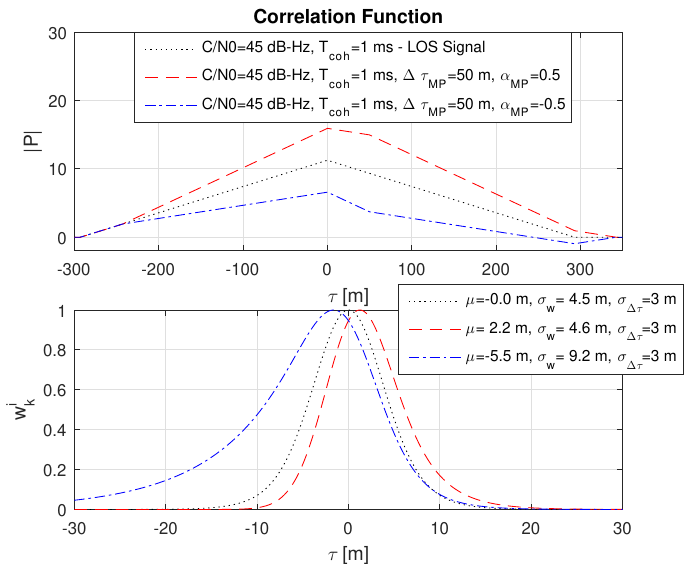
Figure 9. Influence of constructive and destructive multipath on the probability function with a relative multipath offset of ∆ τ MP = 50 m and an amplitude of α MP = 0.5 with respect to the line-of-sight (LOS) signal. The black dotted line refers to the LOS signal. It can be seen that the multipath variants shift the weighted mean µ in the opposite direction and that the destructive multipath significantly increases σ w due to the lower amplitude in | P | .